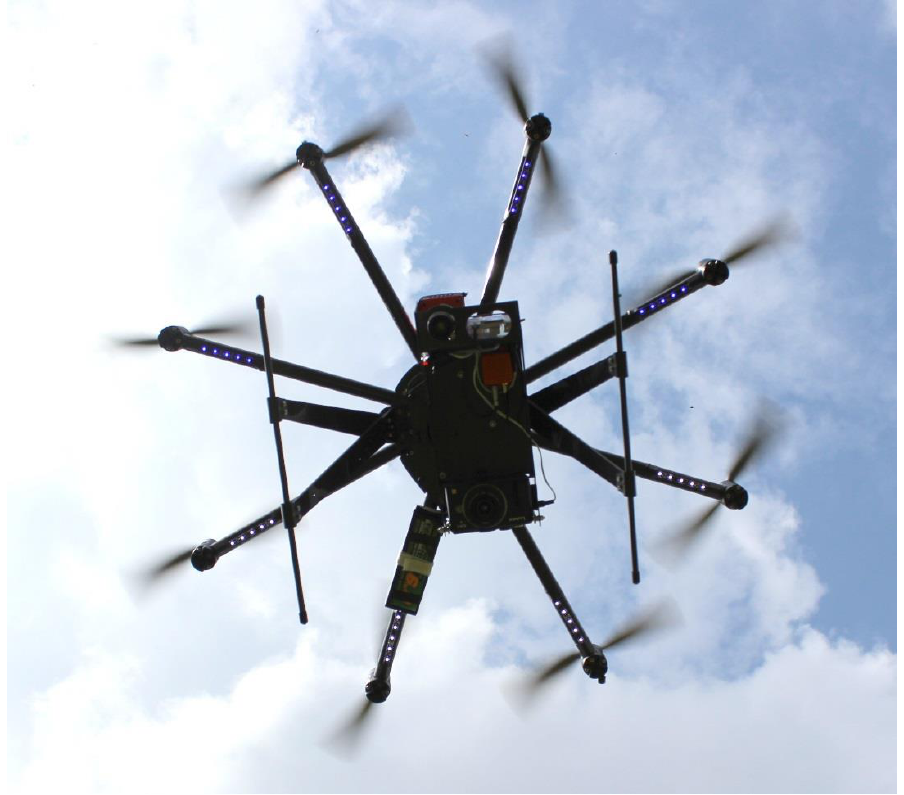
Figure 3. The octocopter UAV Aerialtronics Altura AT8 v1A equipped with all necessary hardware and software tools for its control and